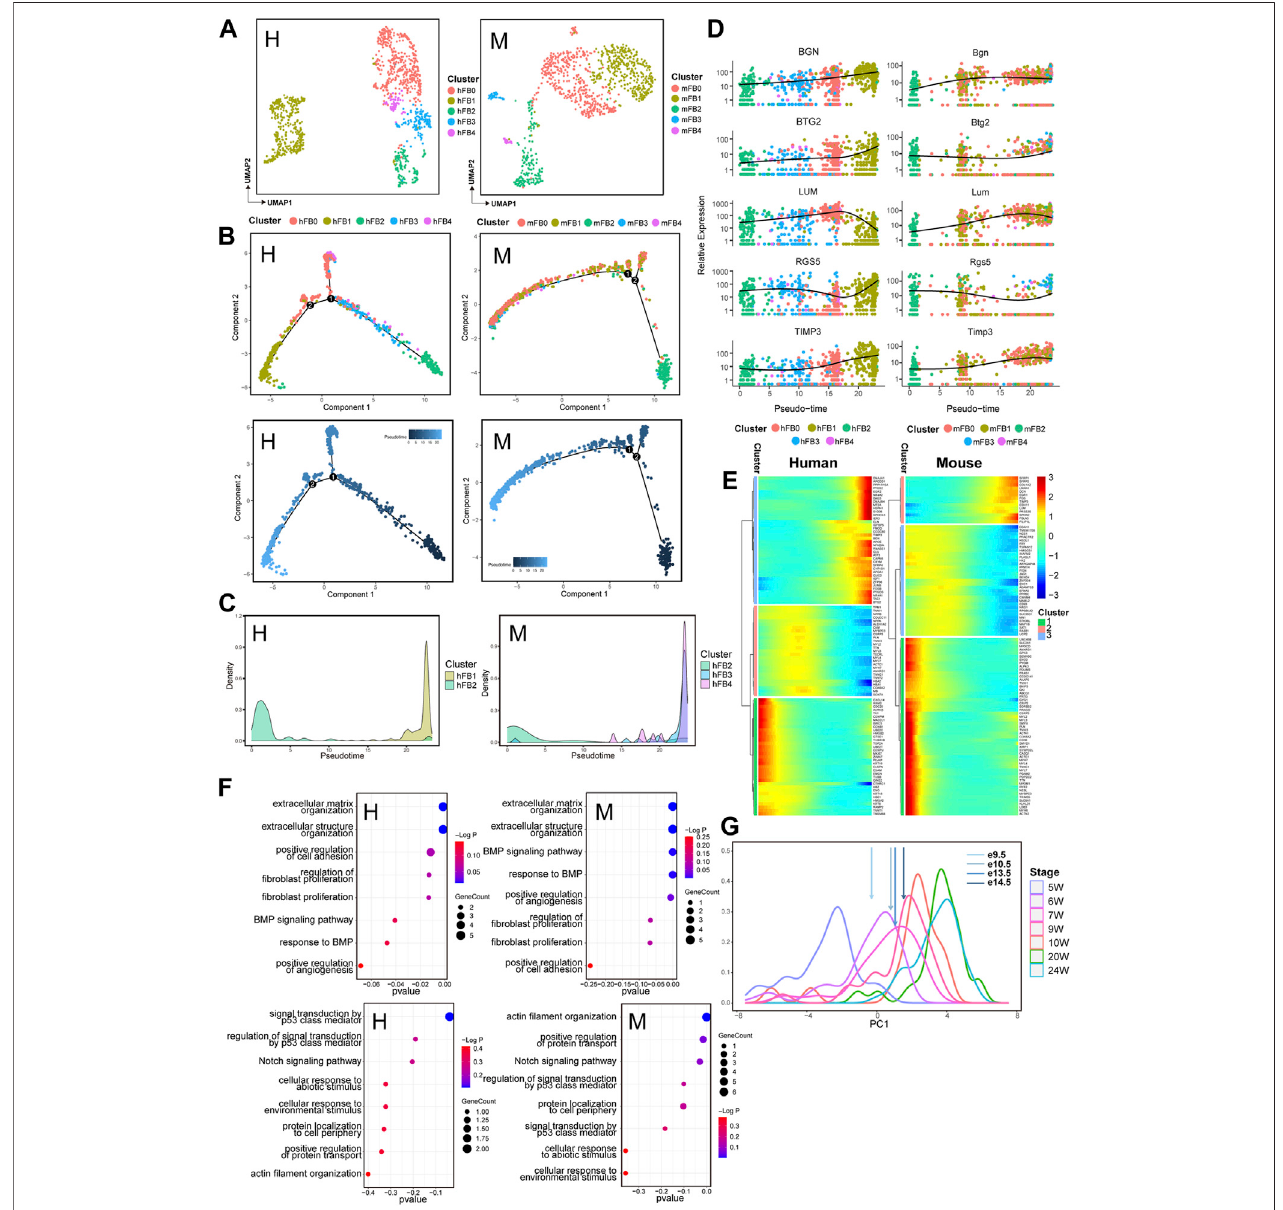
FIGURE 4 | Transcriptomic dynamics of fi broblasts during human and mouse heart development (human: H, left; mouse: M, right). (A) UMAP plots showing the subpopulations of human (H) and mouse (M) fi broblasts. (B) Pseudotemporal trajectory of FB subpopulations constructed by Monocle2. Upper: colored by FB subpopulations; Lower: colored by pseudotime values, with the value ranging from small to large representing the start to the end of the developmental process. (C) Density plot of the distribution of FB subpopulations along the trajectory. (D) Dot plots showing the expression of genes conserved along the trajectory in two species. (E) Heatmap showing the expression pattern of fi broblasts along the developmental trajectory. (F) GO enrichment analysis (BP) of the genes in fi broblasts with different expression patterns along the trajectory between two species. (G) PCA-based density plot depicting the proportion of hFBs at various time points, showing a considerable overlap in temporal development from 5 W to 24 W. The arrows represent the mean expression of different developmental stages of mouse FBs.